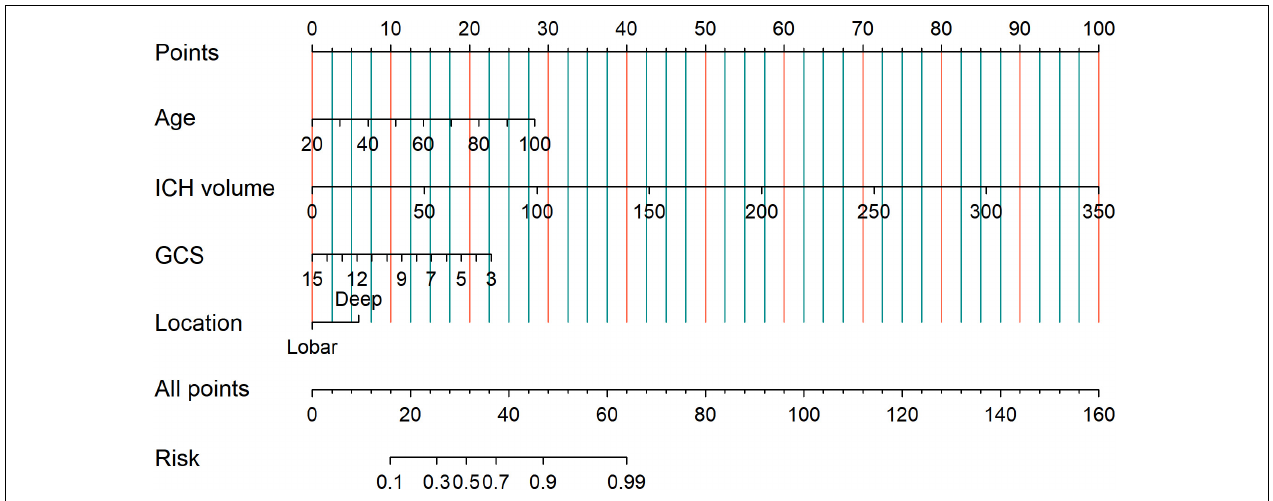
FIGURE 3 | The clinical nomogram for assessing 90-day clinical functional